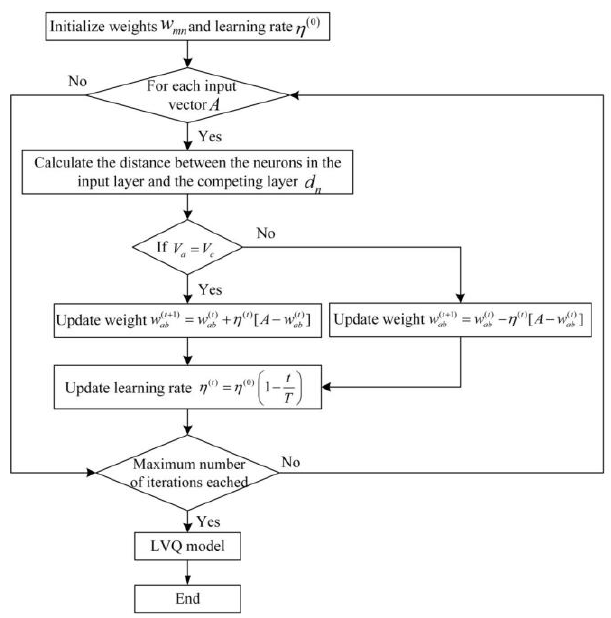
Figure 4. The training steps of LVQ.